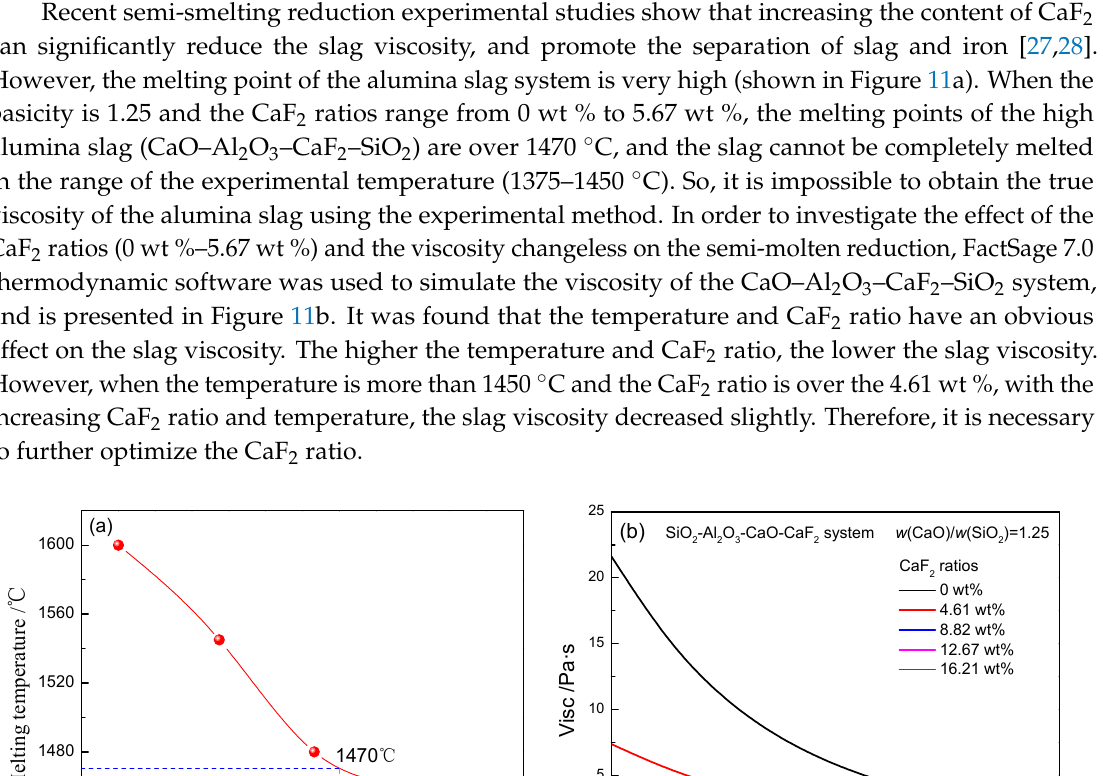
Figure 10. Effect of anthracite ratio on the ( a ) reduction indexes and ( b ) Al 2 O 3 grade.